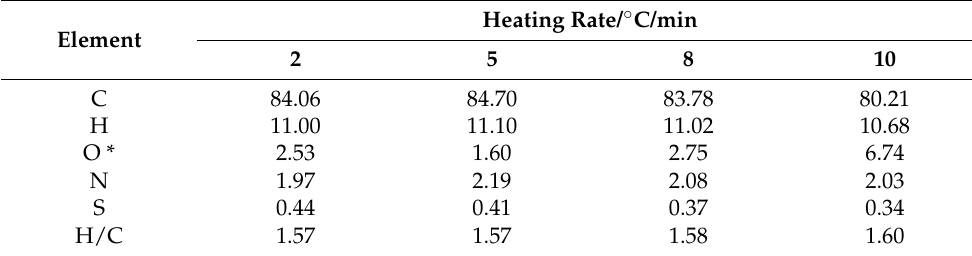
Table 6. Ultimate analysis of the shale oil derived at different heating rates (wt.% of the shale oil).